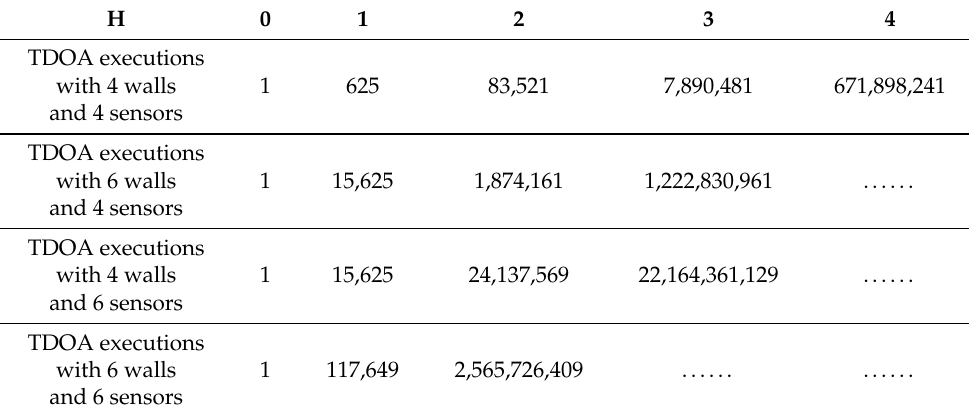
Table 1. Number of executions of the basic TDOA algorithm with four and six sensors. H